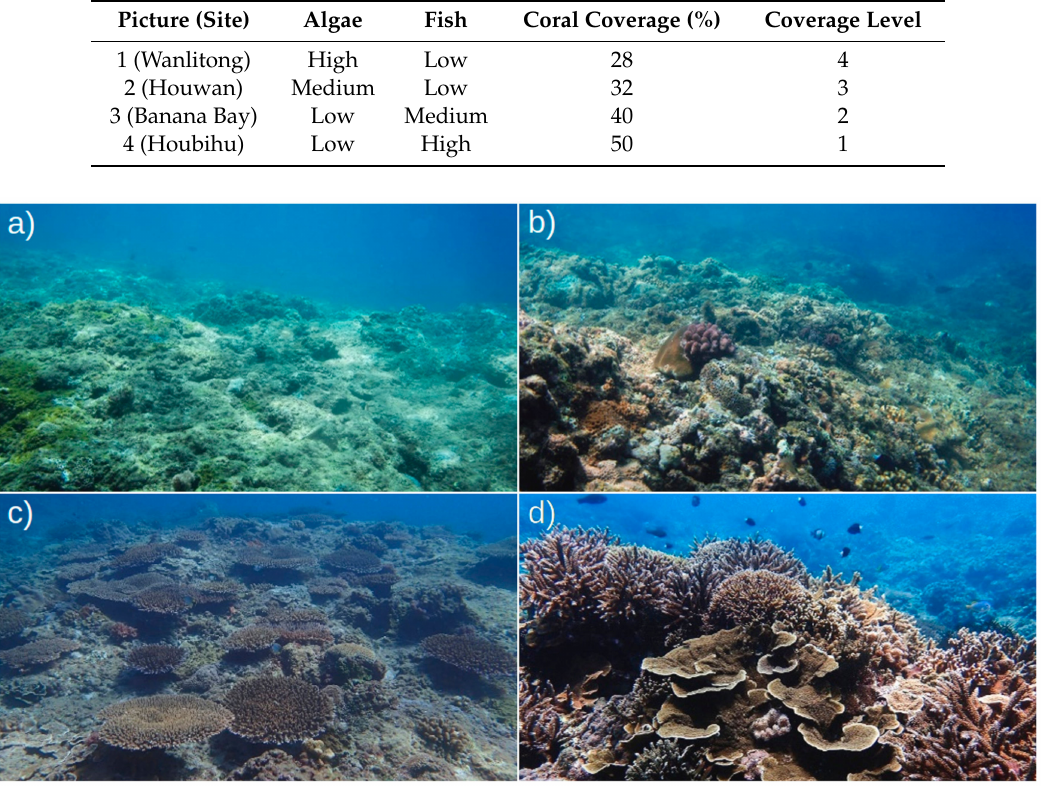
Figure 3. Pictures shown: ( a ) Wanlitong, ( b ) Houwan, ( c ) Banana Bay and ( d )